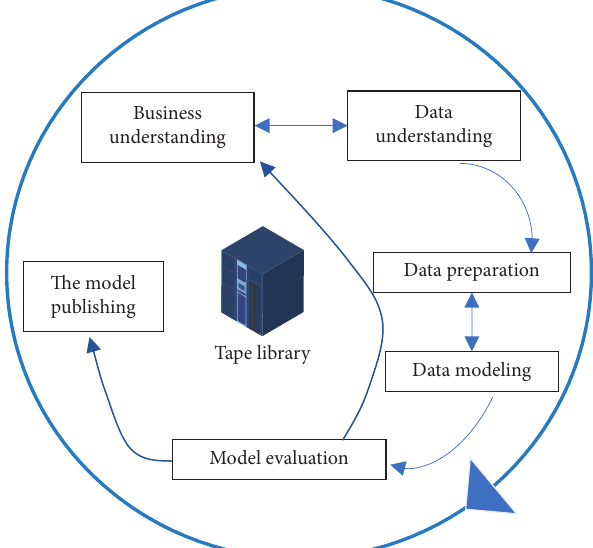
Figure 3: Cross-industry data mining